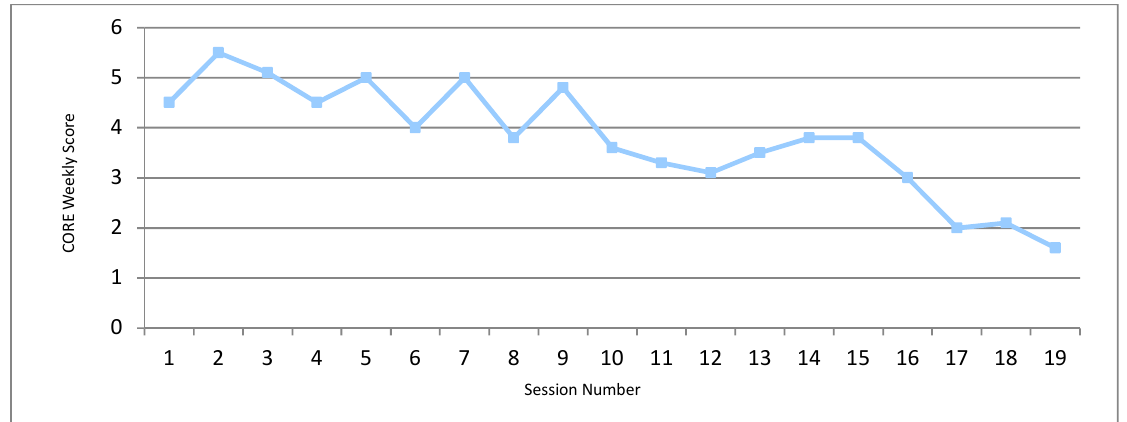
Figure 2: Weekly and Follow-Up mean PQ scores (clinical significance